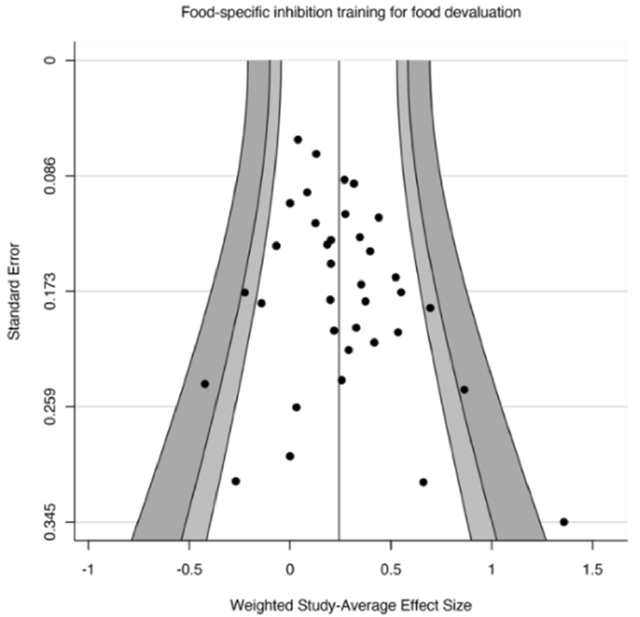
Figure 2. Funnel plot to ascertain evidence for publication bias in food-specific inhibition training on food evaluation.